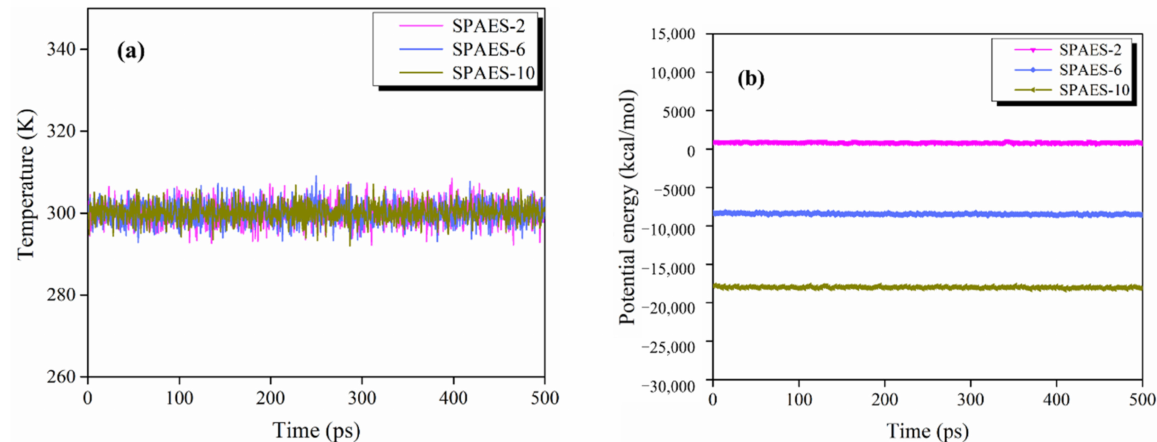
Figure 3. ( a ) Temperature and ( b ) potential energy variation of the